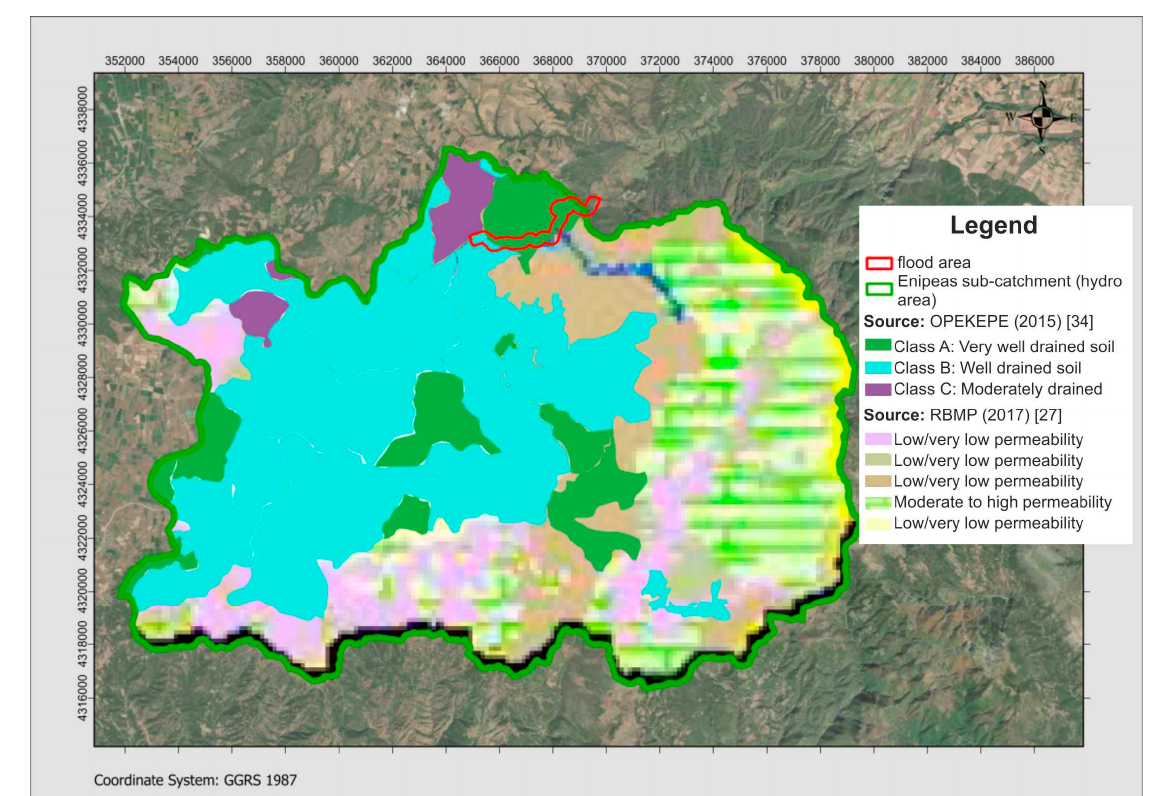
Figure 5. Hydrolithological map of the study area by merged OPEKEPE [34] and RBMP [27] data (see SM11).